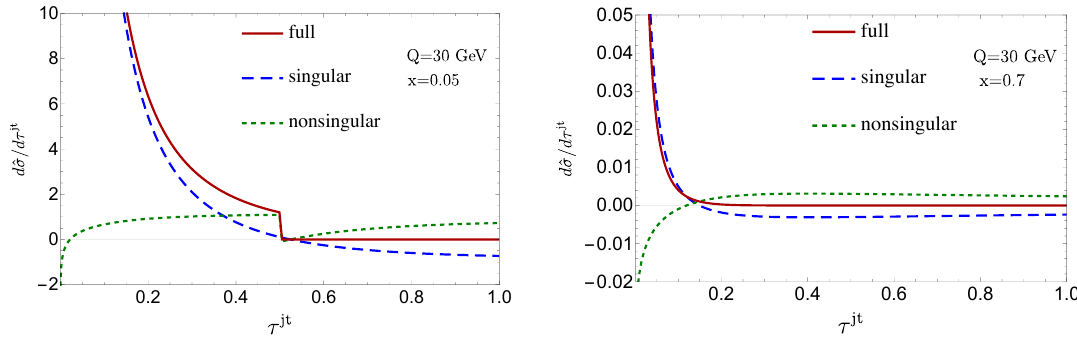
Figure 2 . Differential τ jt cross section at Q = 30 GeV and x = 0 . 05 and 0.7. Singular (blue dashed), nonsingular (green dotted), and their full (red solid)